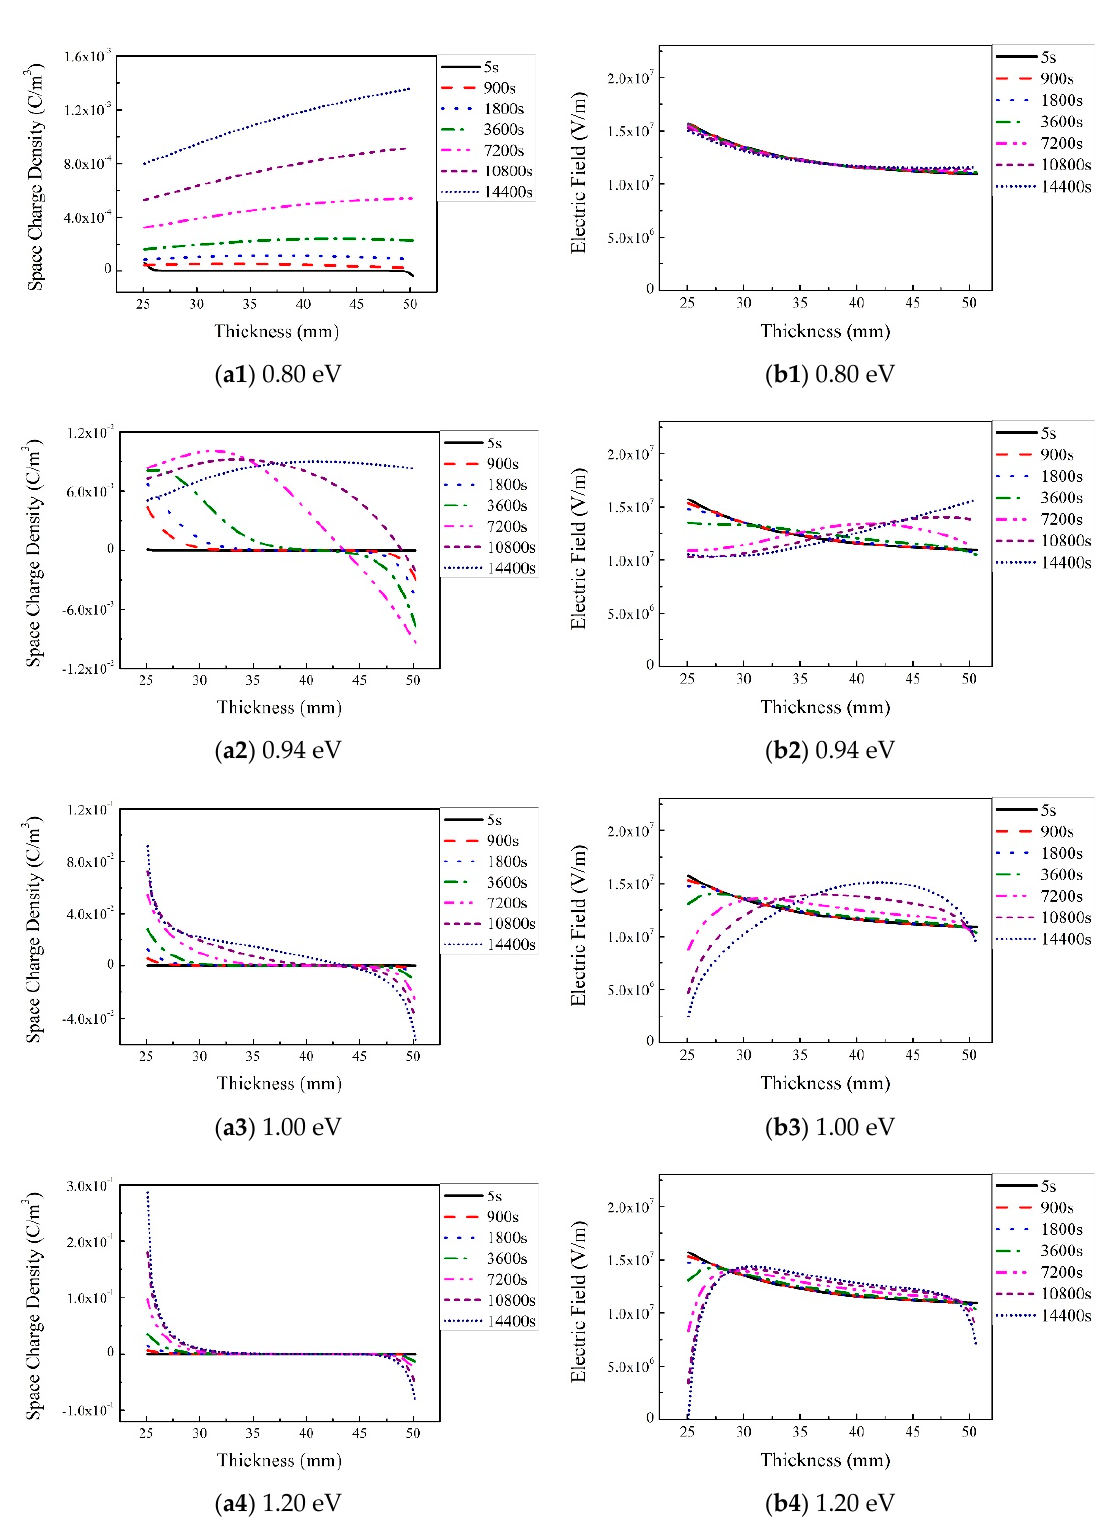
Figure 4. Simulation results of space charge distribution ( a1 - a4 ) and electric field distribution ( b1 - b4 ) in 320 kV HVDC cable insulation when the trap depth varies from 0.8 to 1.20 eV with the trap density of 200 × 10 19 m − 3 and load current of 1800 A.